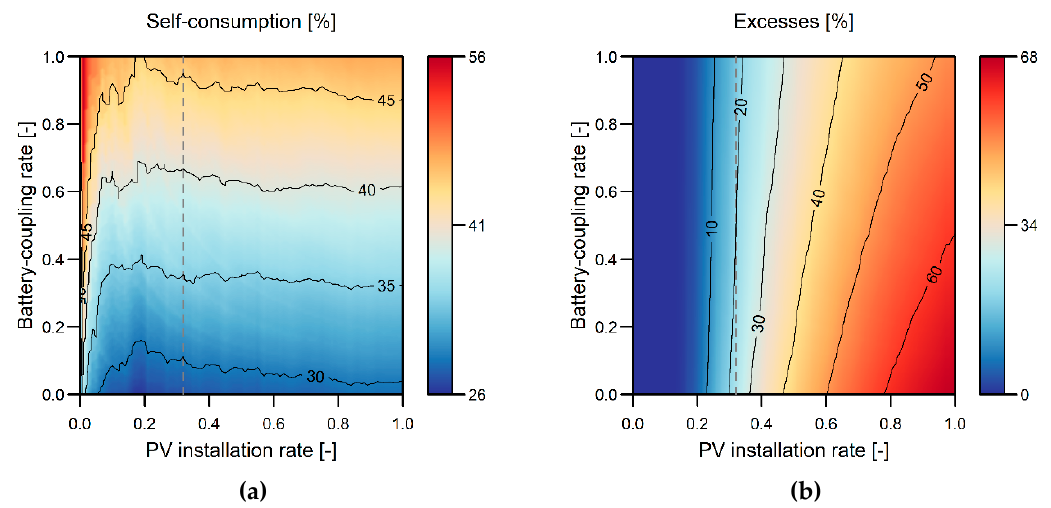
Figure 5. ( a ) Self-consumption and ( b ) energy excesses for different PV installation and battery-coupling rates as percentage of consumption (with the PV installation rate of 32% in dashed grey).